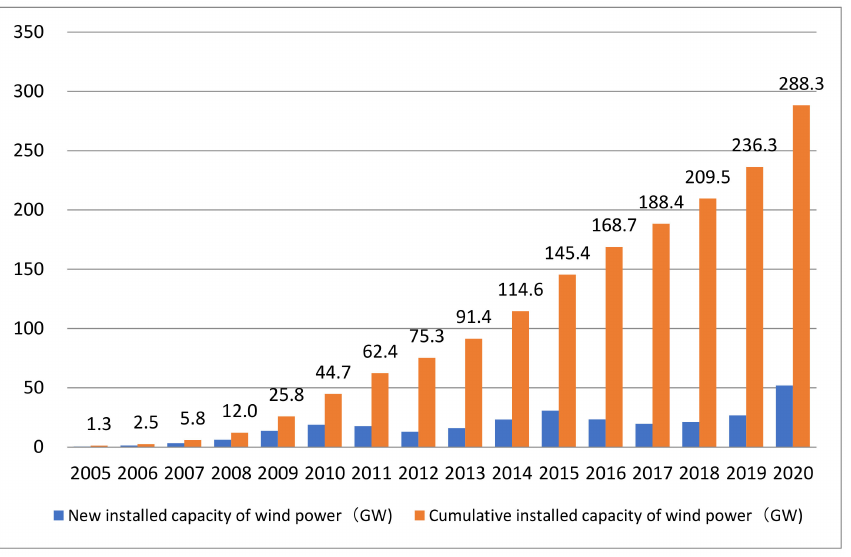
Figure 2. New and cumulative installed wind power capacity in China. (Data source: China’s wind power installed Capacity Statistics 2006–2020; BP Statistical Review of World Energy